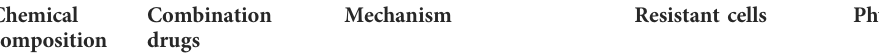
TABLE 2 Effect of S. miltiorrhiza bioactive compounds combined with chemotherapy and